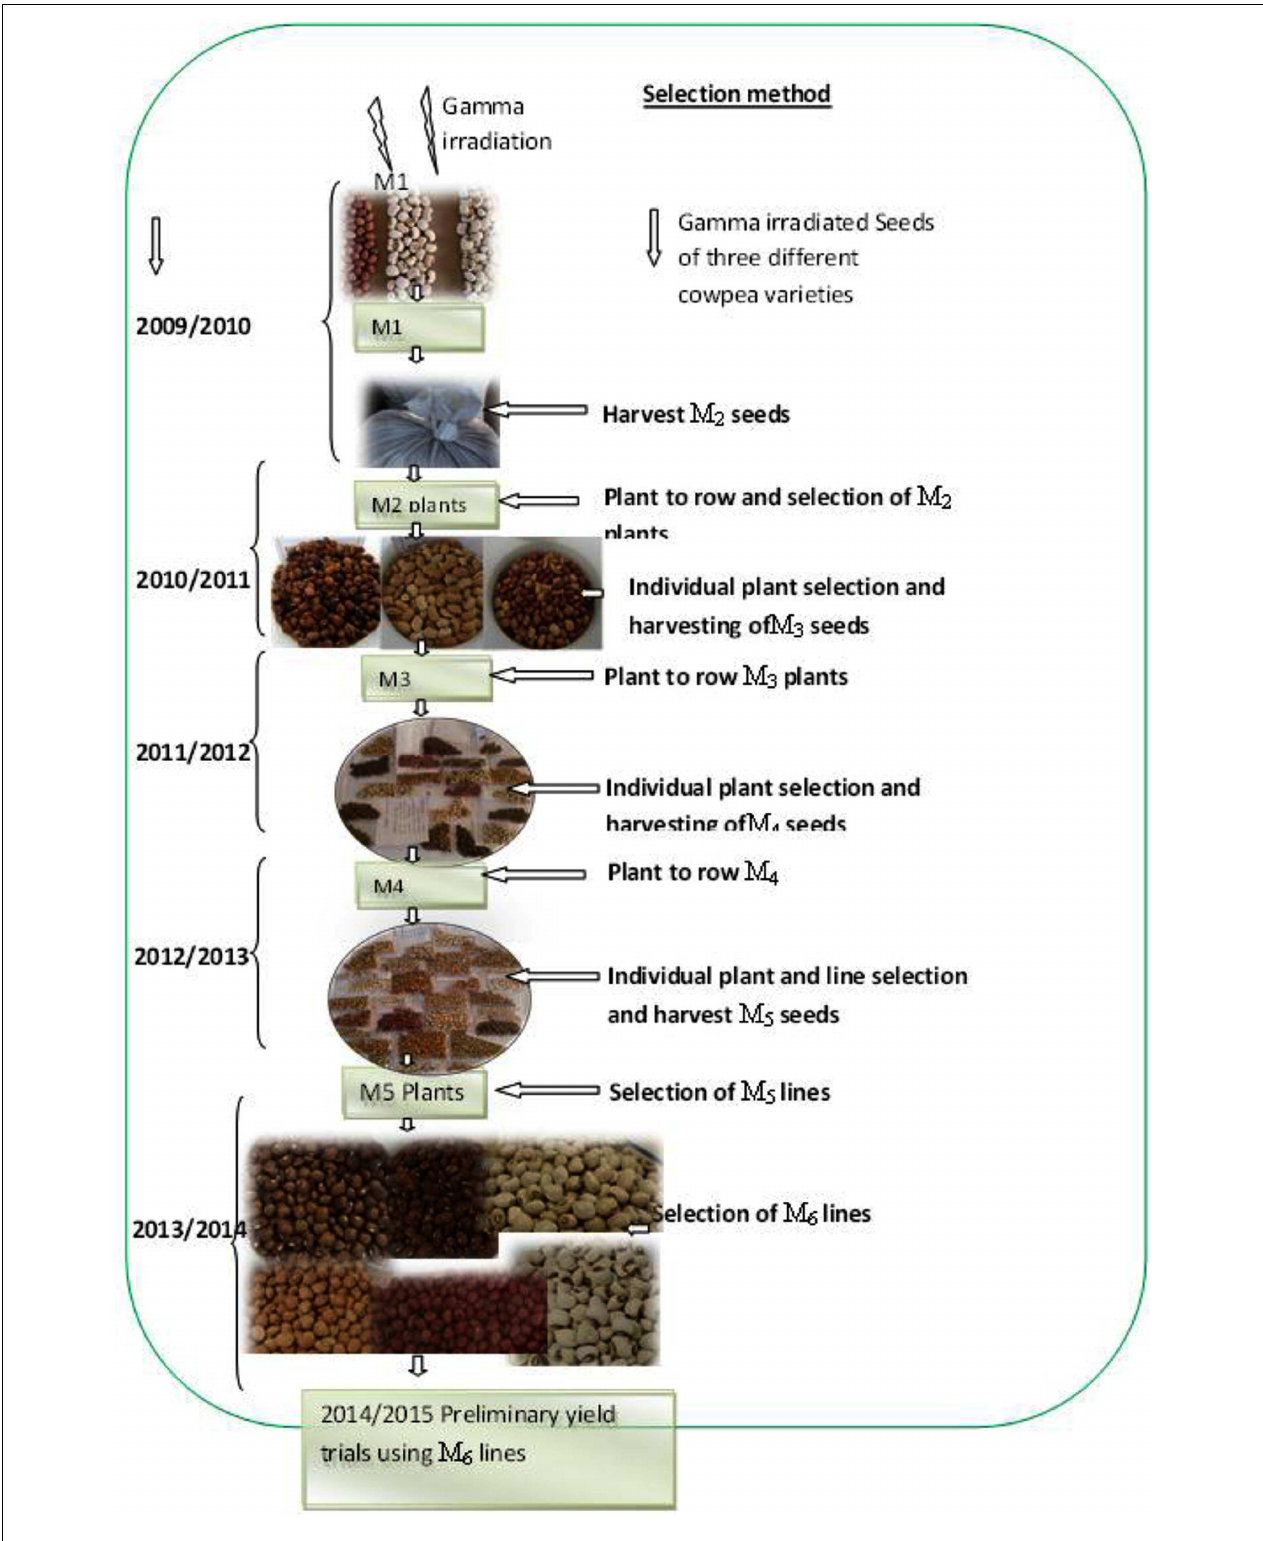
FIGURE 1 | Illustration of the selection methods during 2009–2014.